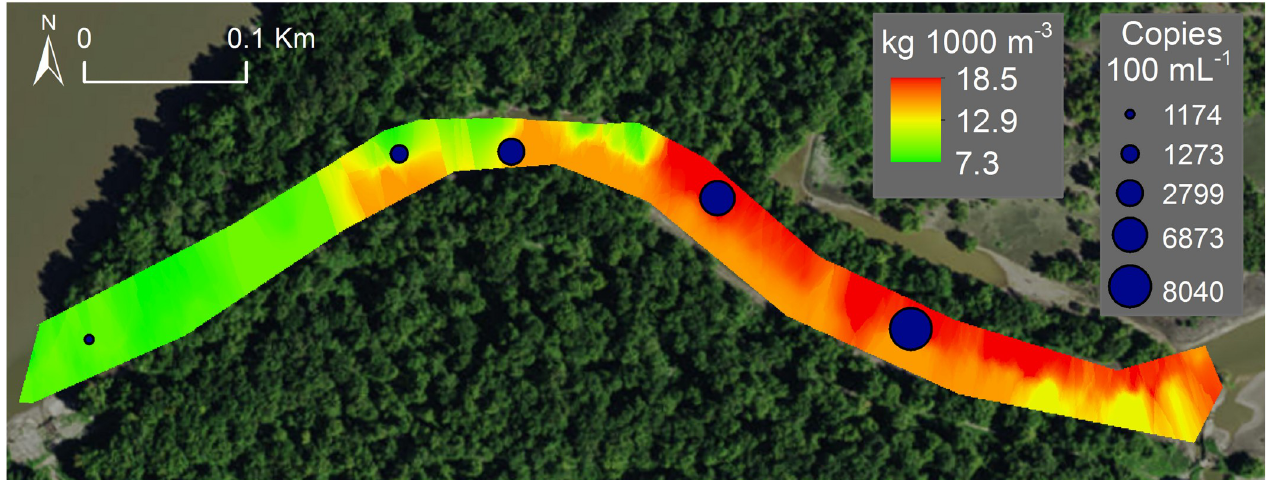
Fig 4. Example of spatial relationships within a site between Silver Carp biomass density (kg � 1000 m -3 ) determined from mobile hydroacoustic sampling and eDNA concentration (SC-TM4 marker) from surface water at a side channel habitat in the LaGrange Reach of the Illinois River, USA.